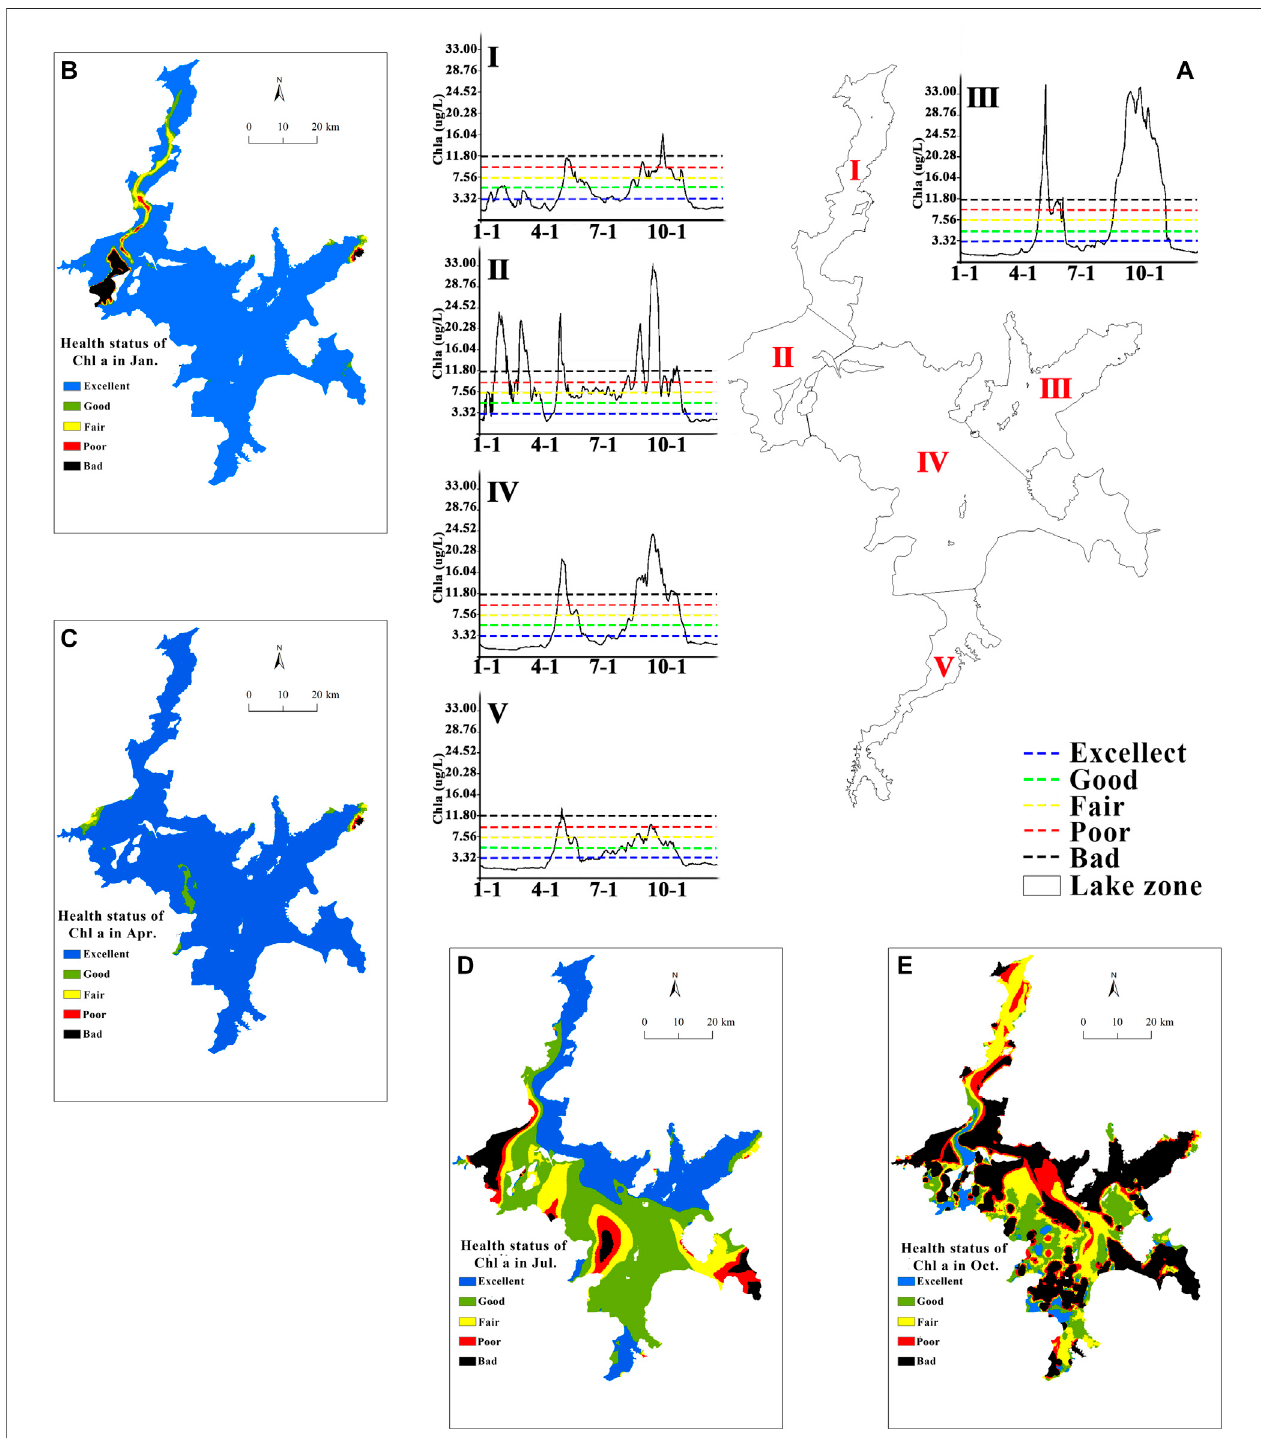
FIGURE 9 | Real-time health assessment curves and spatiotemporal distributions of Chl a in the lake zones of Lake Poyang in 2015. (A) Real-time health assessment curves of Chl a, (B – E) spatiotemporal distributions of Chl a in Jan.,Apr.,Jul.,Oct.